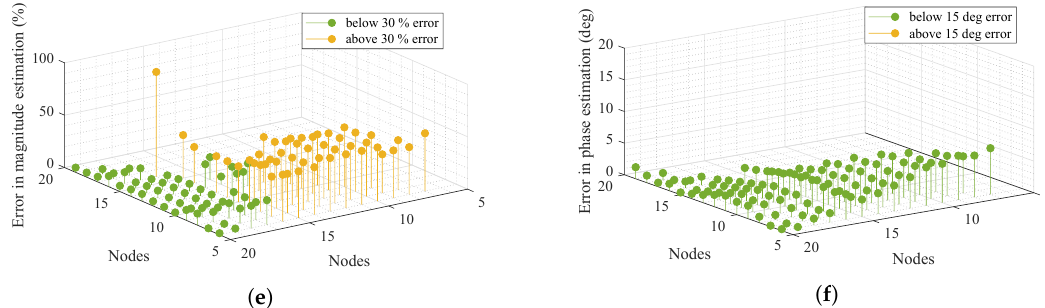
Figure 11. Error is estimation of unbalance ( a ) magnitude and ( b ) phase for case 1, ( c , d ) for case 2, and ( e , f ) for case 3 with different combinations of two measured nodes from the experimental